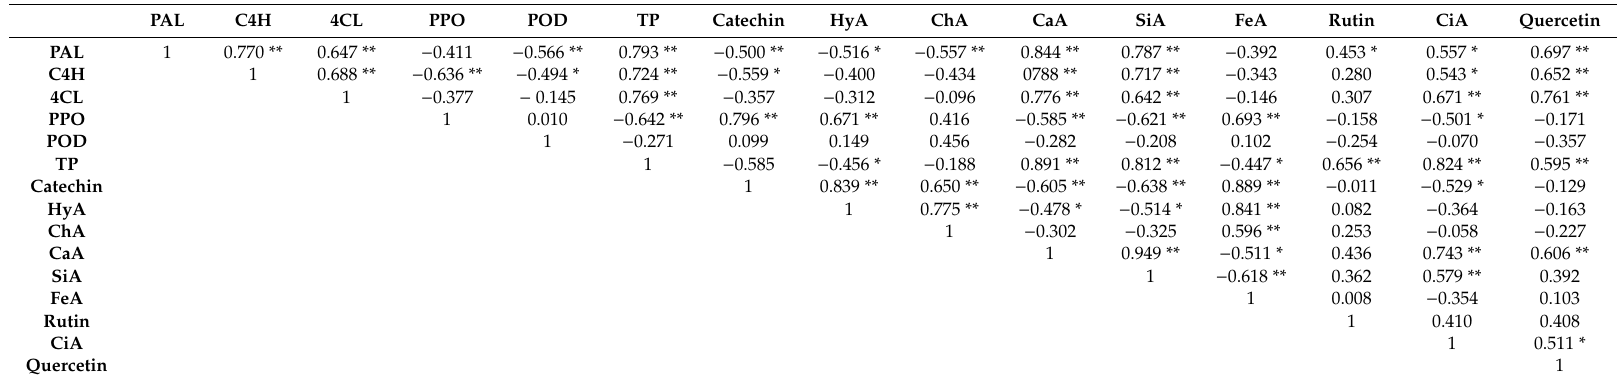
Table 2. Pearson correlation coe ffi cients of nine kinds of individual phenols, total phenol (TP) content, PAL, C4H, 4CL, PPO, POD enzyme activities. CiA, CaA, SiA, ChA, FeA, and HyA represent cinnamic acid, ca ff eic acid, sinapic acid, chlorogenic acid, ferulic acid, and hydroxybenzoic acid, respectively. PAL C4H 4CL PPO